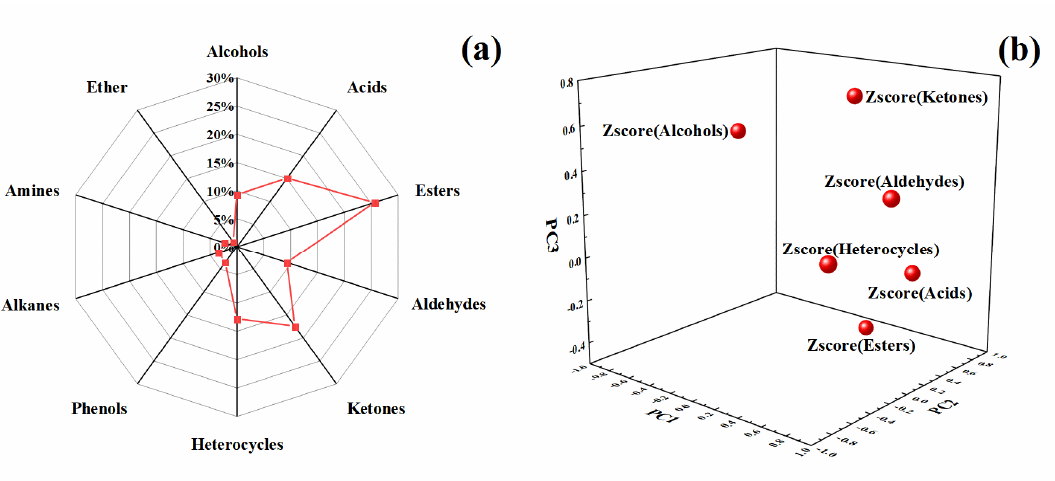
Figure 4. Ratio of functional groups of ice cream samples ( a ) and Volatile aroma loading diagram of ice cream samples ( b ).